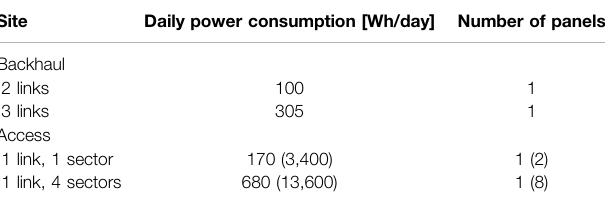
TABLE 5 | The required daily power consumption for a few backhaul and access sites. The numbers in brackets are for 16QAM. The number of panels is calculated based on 1,700 Wh daily